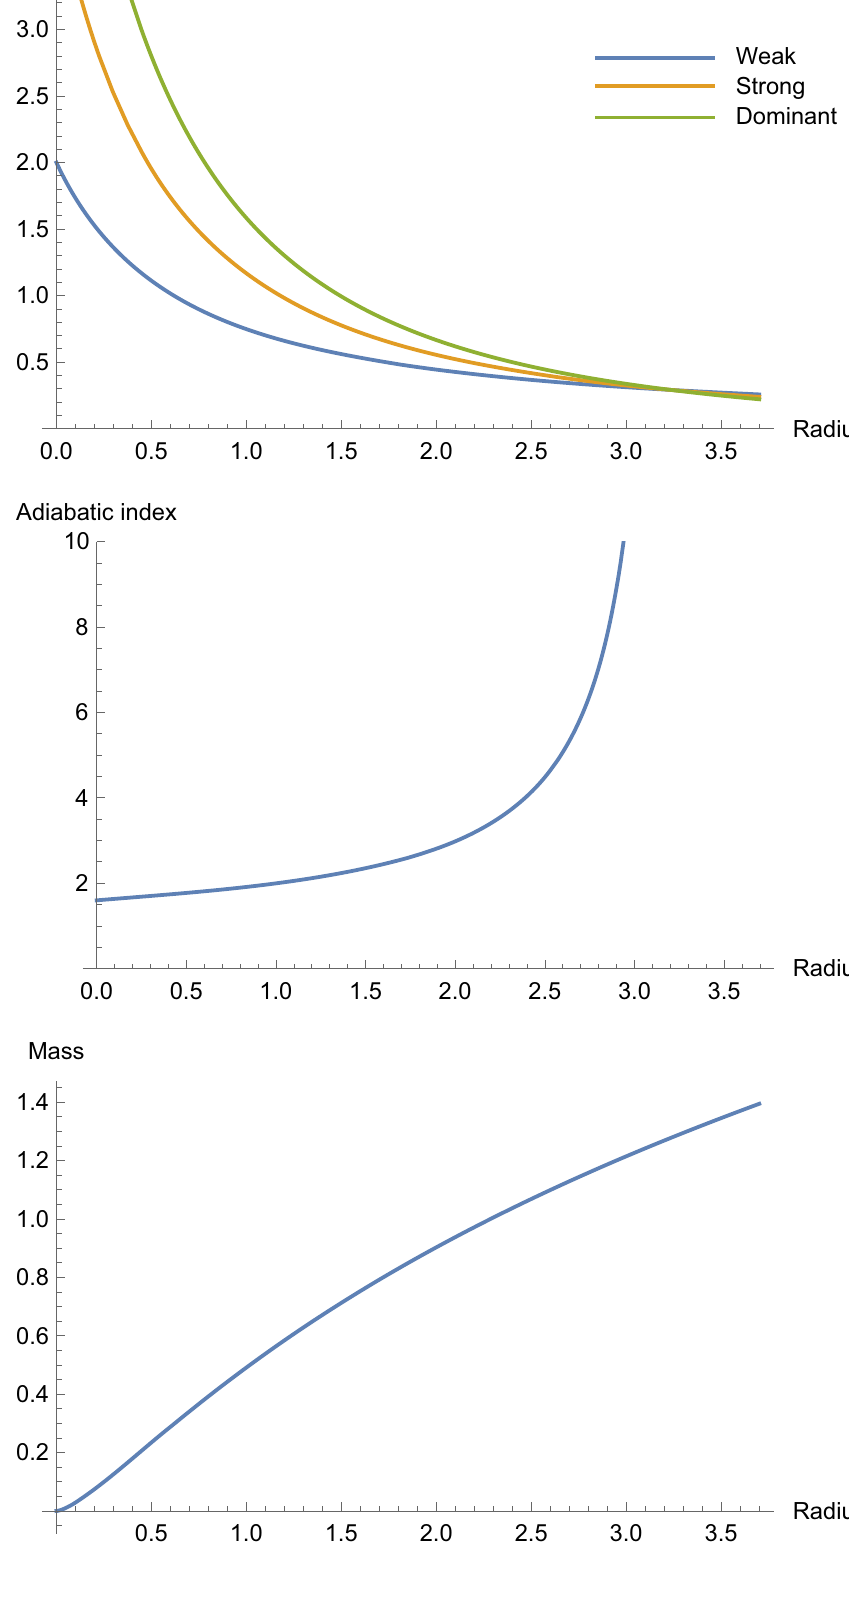
Fig. 6 Mass profile versus the radial variable